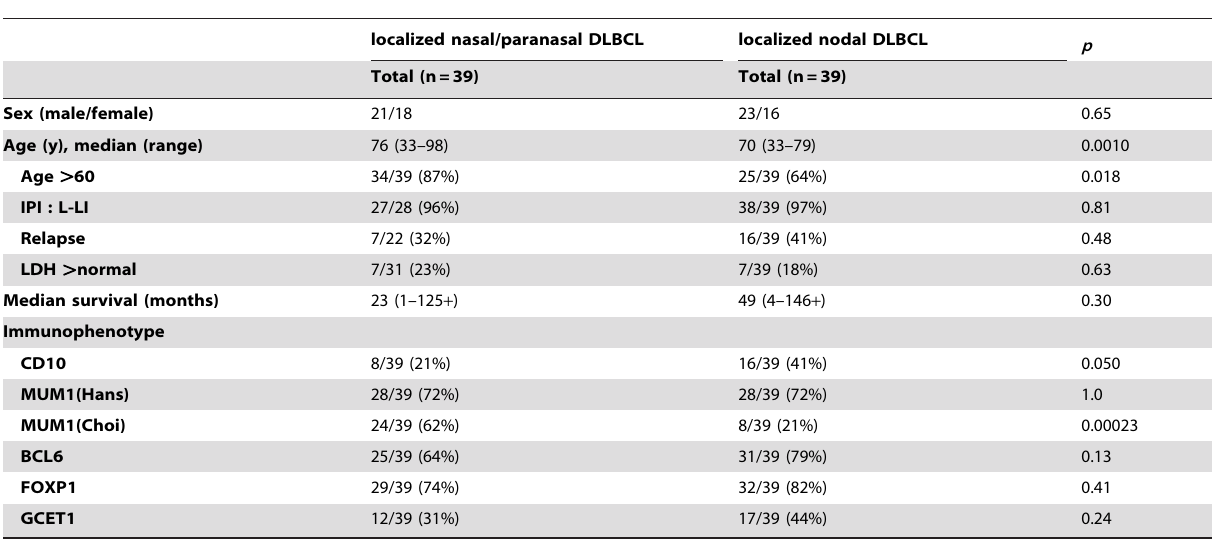
Table 5. Clinical and phenotypic characteristics of patients with localized nasal/paranasal DLBCL and localized nodal